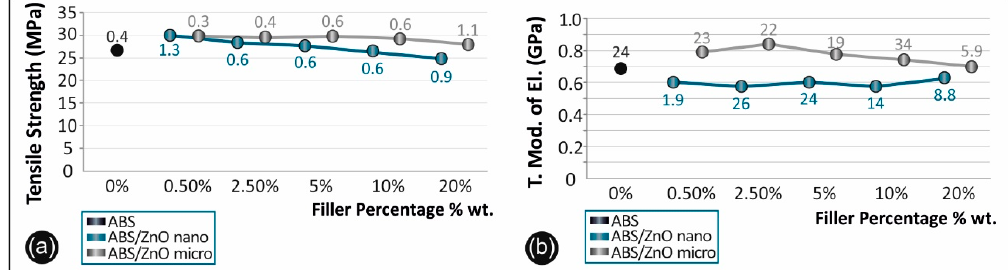
Figure 7. ( a ) Tensile stress vs. strain graphs for ABS/ZnO nano and ( b ) ABS/ZnO micro.